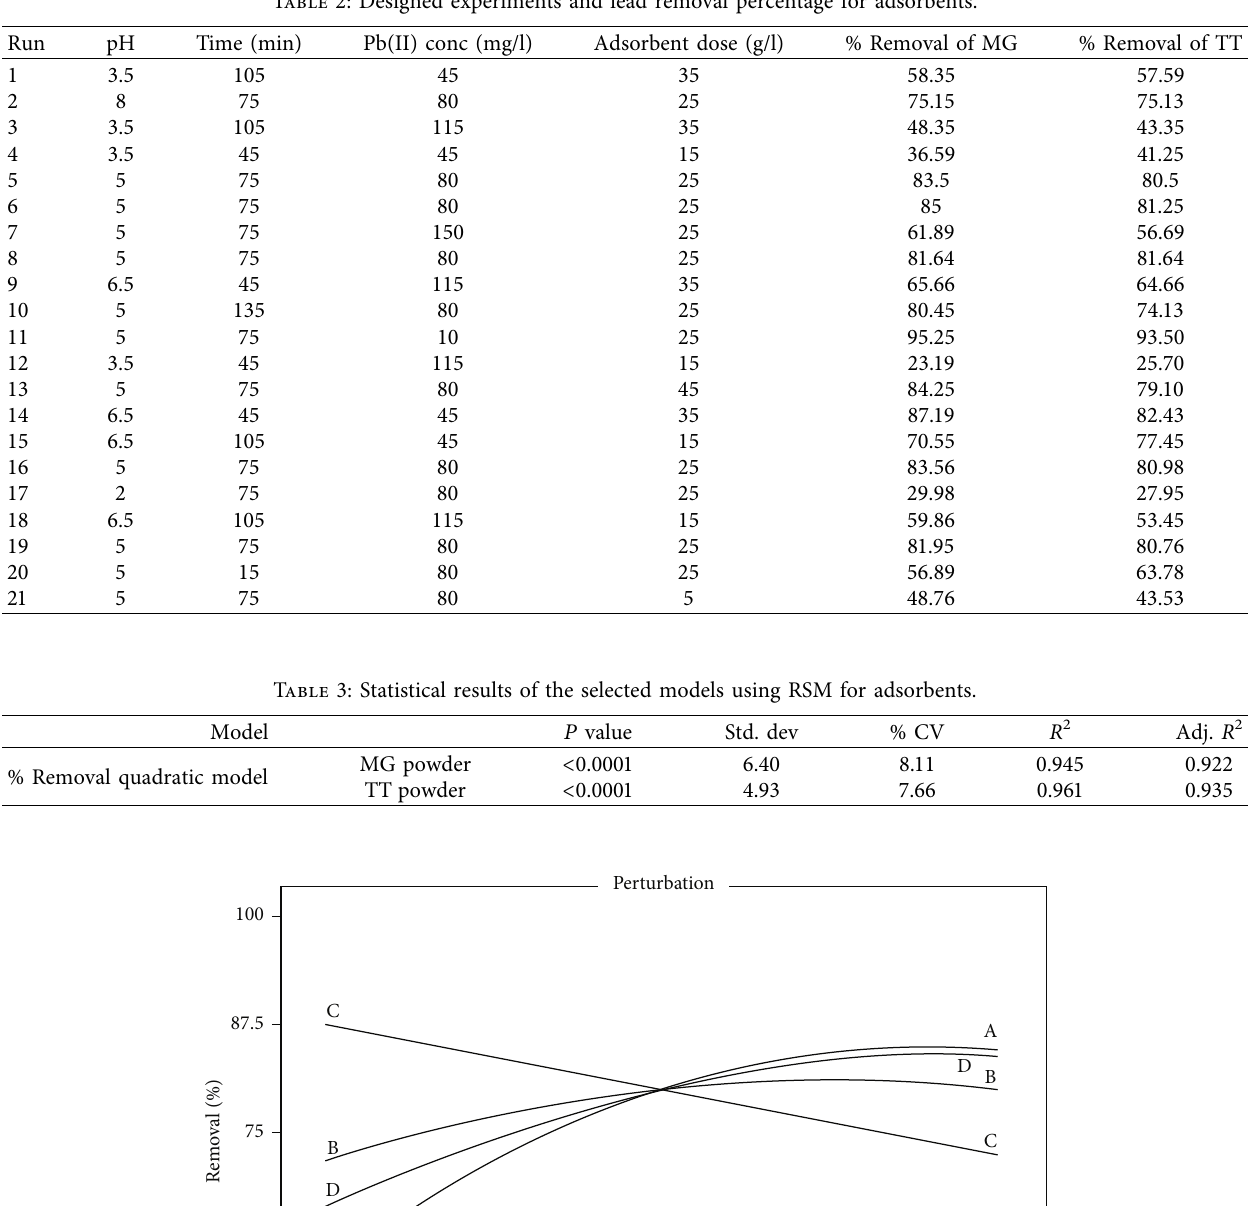
Table 2: Designed experiments and lead removal percentage for adsorbents.